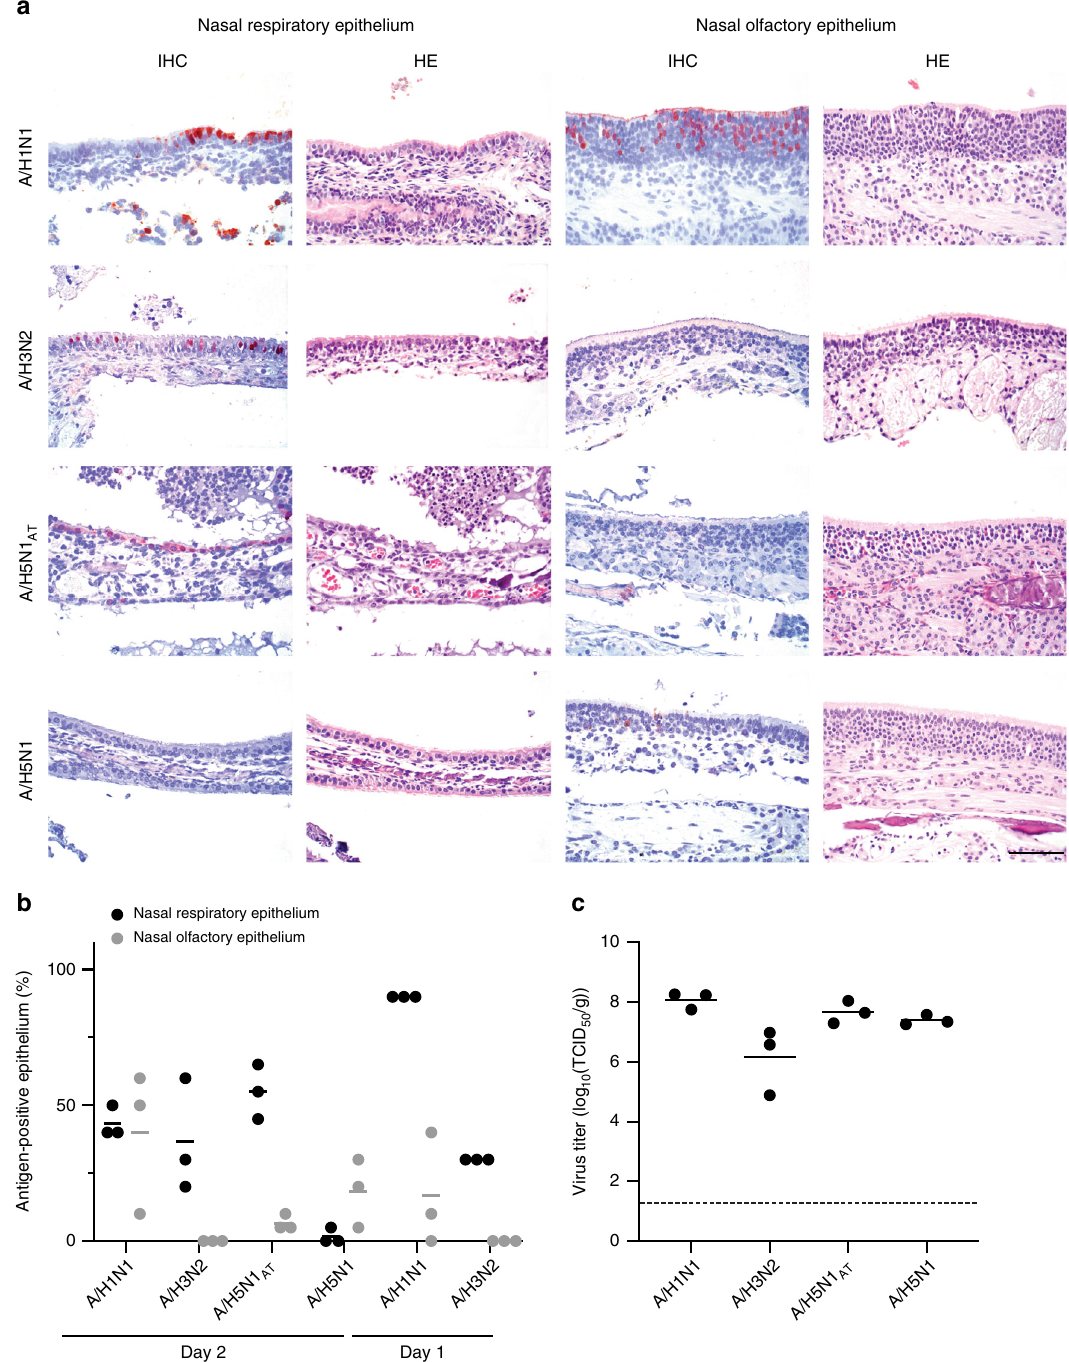
Fig. 3 Airborne transmissible in fl uenza A viruses infected the nasal respiratory epithelium of ferrets. a Representative pictures of ferret nasal respiratory and nasal olfactory epithelia 2 days after intranasal inoculation with A/H1N1, A/H3N2, A/H5N1 AT or A/H5N1 viruses. In fl uenza A virus nucleoprotein expression was determined by immunohistochemistry (IHC) and is shown as a red stain. HE: hematoxylin-eosin stain. Scale bar 50 μ m. b Percentage of epithelium that was nucleoprotein antigen-positive, as determined by IHC, were blindly assessed in the nasal respiratory epithelium (black) and nasal olfactory epithelium (light gray) of three ferrets inoculated with the respective viruses. Individual percentages are shown. Means are depicted by the horizontal lines. c Individual virus titers in the homogenized nasal turbinates (containing both nasal respiratory and olfactory epithelia) were determined by end-point titration in MDCK. Means are depicted by the horizontal lines. The limit of detection of the virus titration is shown by the dotted line. Source data are provided as a Source Data fi